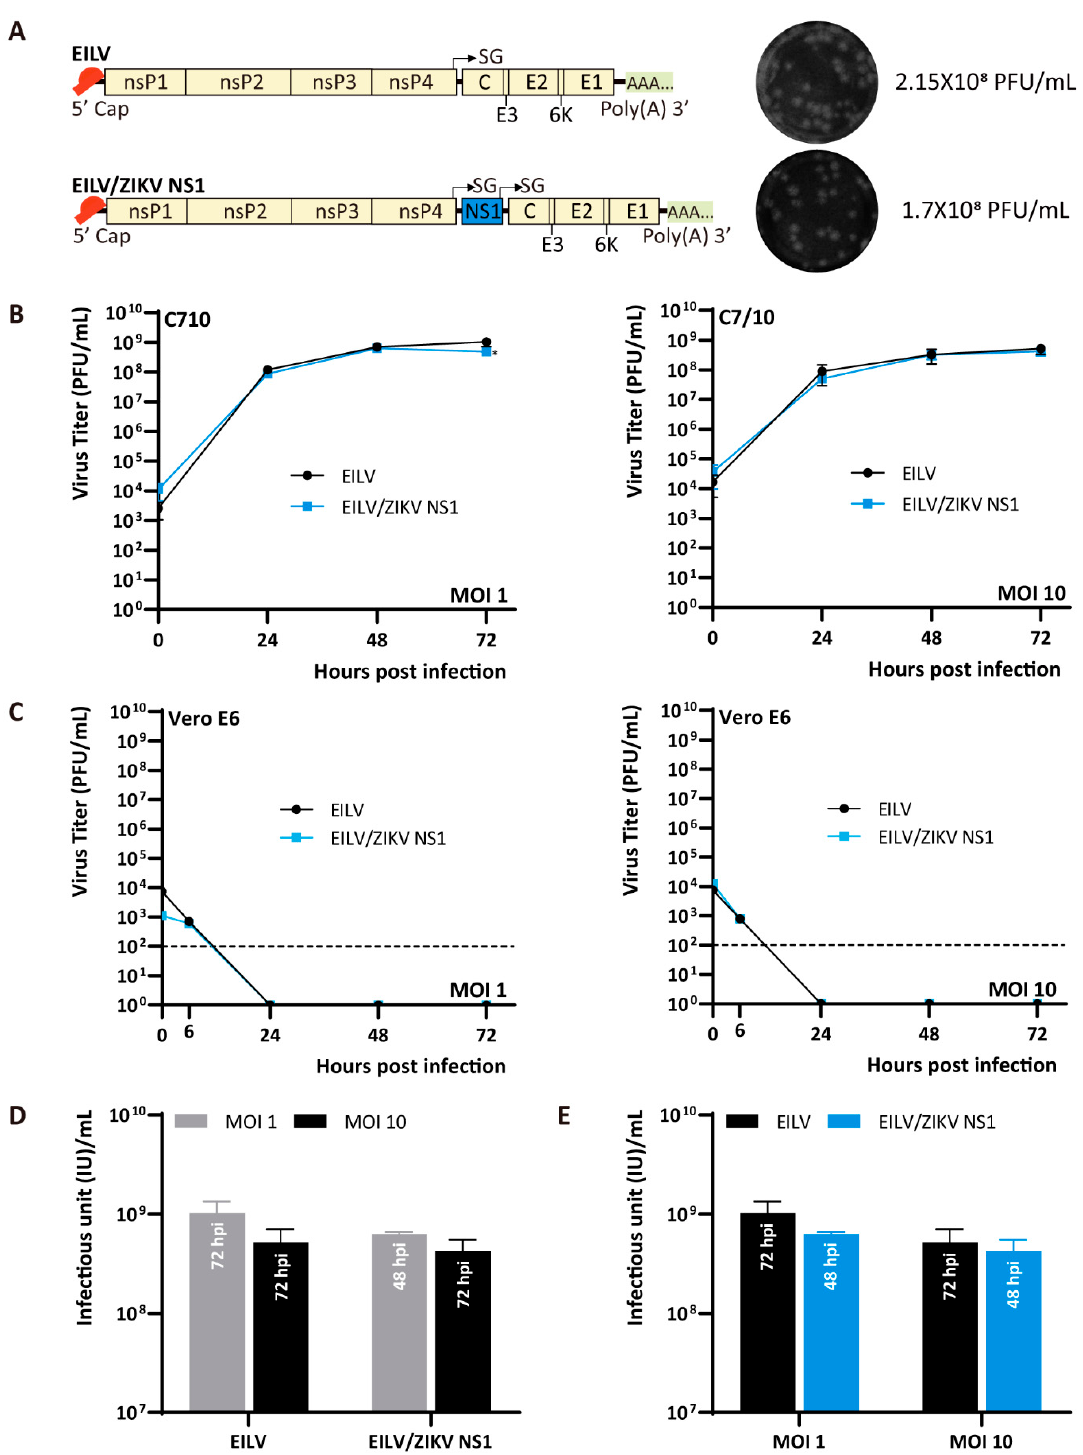
Figure 4. Genome organization and replication kinetics of EILV-based double subgenomic (SG) variant expressing Zika virus (ZIKV) nonstructural 1 (NS1) protein. ( A ) Genome organization of EILV/ NS1 recombinant. Virus was rescued on C7/10 cells and harvested at 3 dpe. Rescue titers and plaque phenotypes are displayed. ( B ) Replication kinetics in C7/10 and Vero E6 cells. C7/10 or Vero E6 cells were infected at an MOI of 1 or 10. Media were collected at the indicated time points post-infection, and titers were determined by plaque assay. ( C ) The optimal titers obtained by each virus with different MOIs. ( D ) Comparison of the optimal titers produced by EILV and EILV/NS1. The annotation embedded in each bar in ( D ) and ( E ) indicates the time point of reaching the highest titer. Each sample was titrated twice ( n = 2). Average titers ±SD (error bars) are shown. *, p < 0.05.